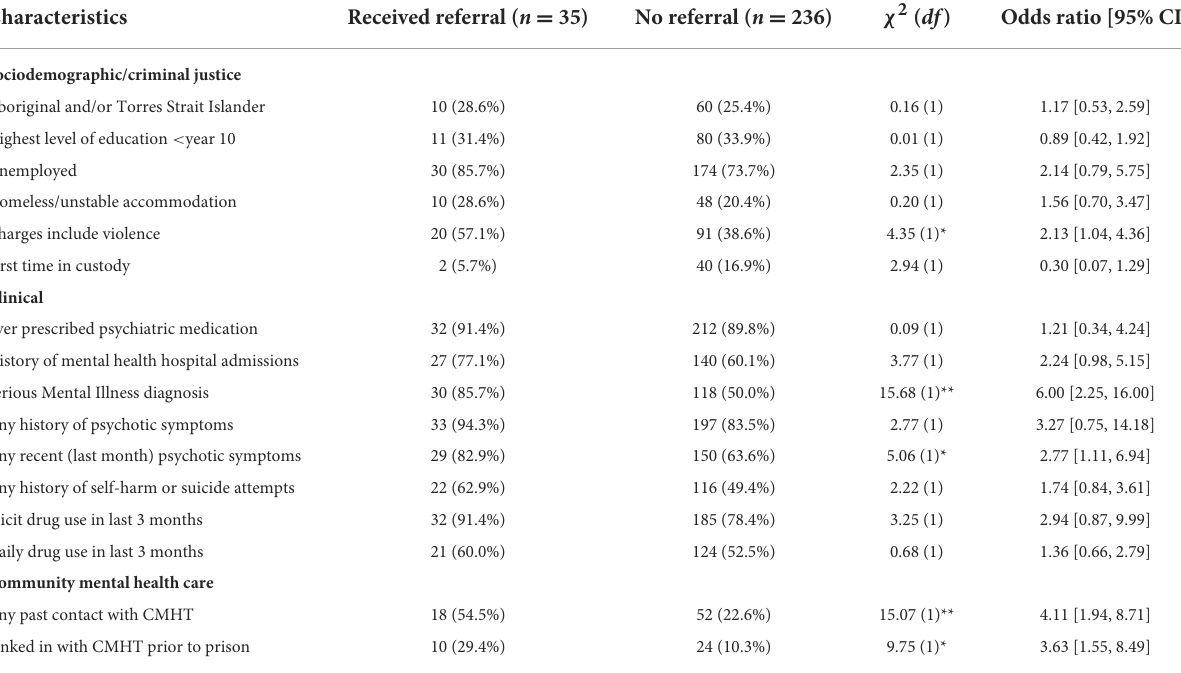
TABLE 4 Comparison of characteristics of participants who received a referral or order for mental health care post-release, with those not referred. Characteristics